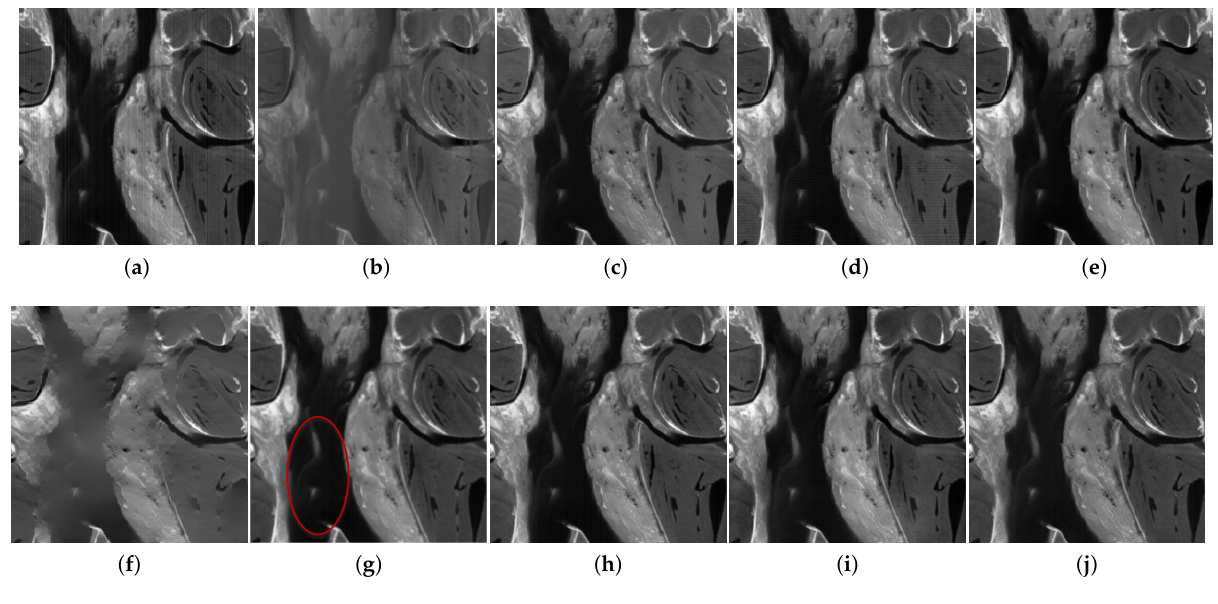
Figure 11. Corrected CHRIS_UK images for band 3. ( a ) CHRIS_UK image. Images corrected by